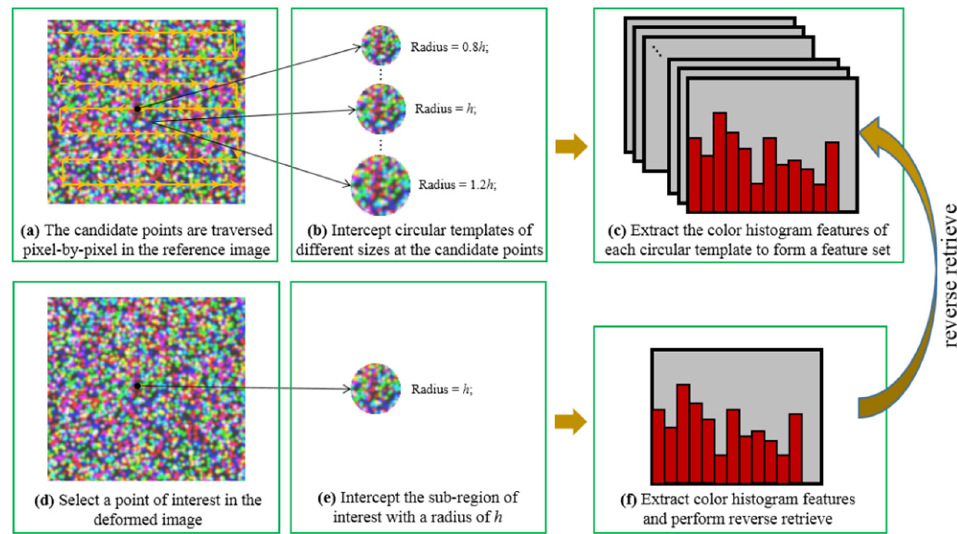
Figure 2. Detailed flowchart of the scaling- and rotation-invariant integer-pixel matching algorithm based on color histogram features.